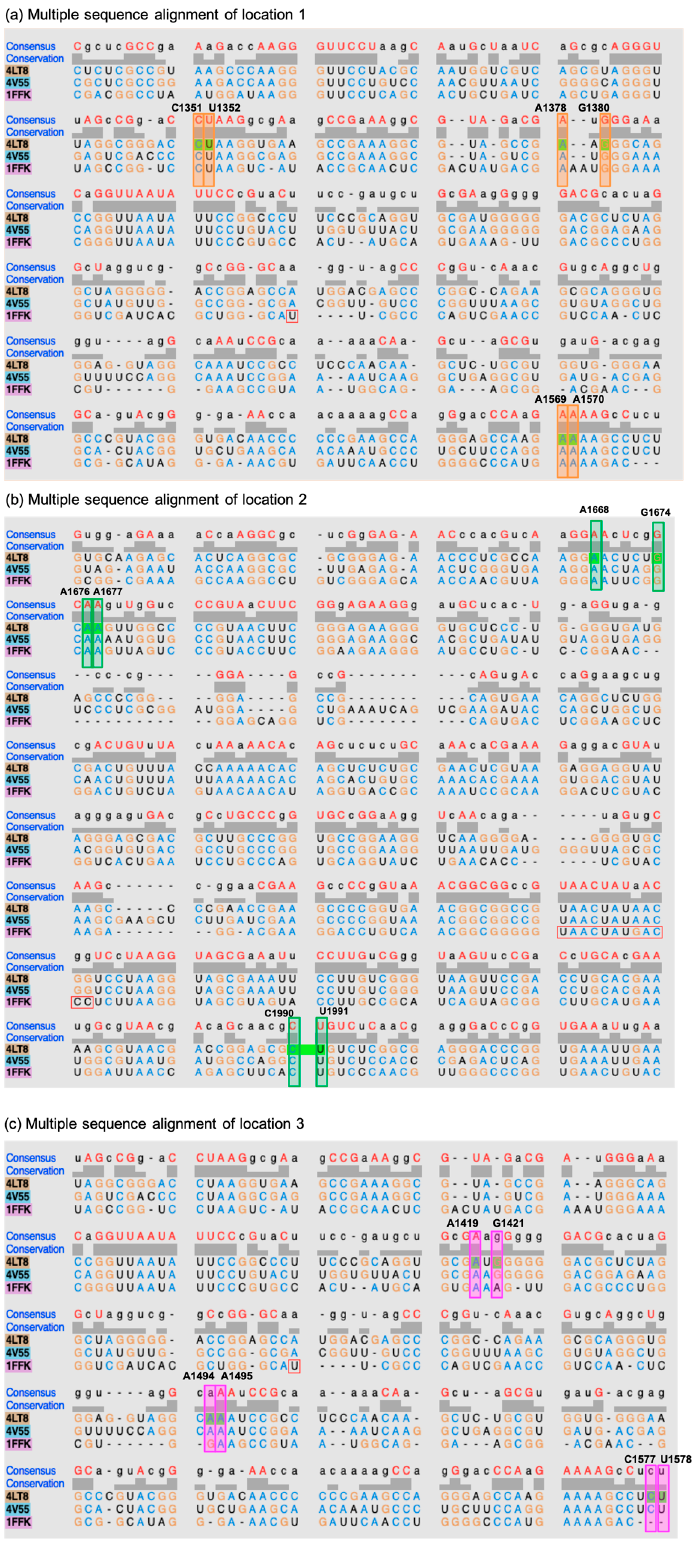
Figure 7. The UAAGAC base sextuples that were annotated in three locations in the sequences of the same RNA molecule, the large ribosomal subunit structures of H. marismortui (PDB ID: 1FFK), T. thermophilus (PDB ID: 4LT8), and E. coli (PDB ID: 4V55). (a) Multiple-sequence alignment of location 1 (partial sequences shown); (b) multiple-sequence alignment of location 2 (partial sequences shown); (c) multiple-sequence alignment of location 3 (partial sequences shown).